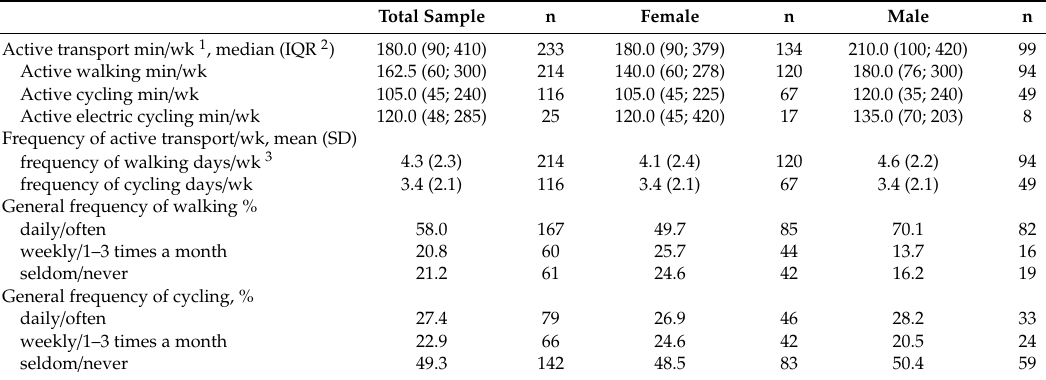
Table 2. Active transport of the study